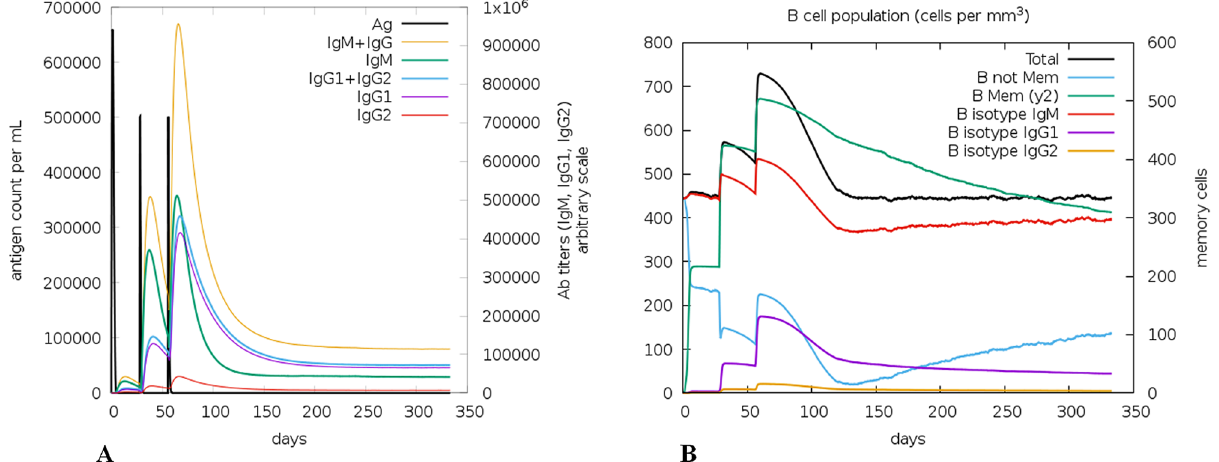
Figure 8. C-ImmSim presentation of an in silico immune simulation with the construct. ( A ) Immunoglobulin production in response to antigen injections (black vertical lines); specific subclasses are showed as colored peaks. ( B ) The evolution of B-cell populations after the three